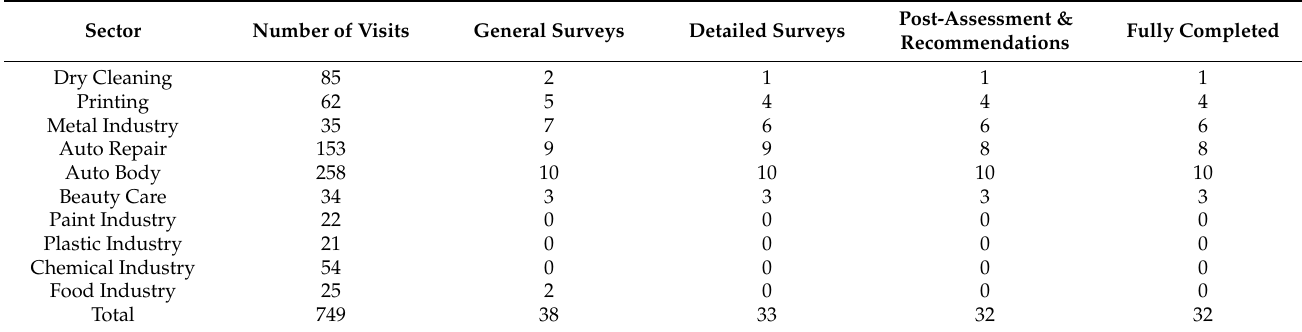
Table 2. Sector specific information on P2